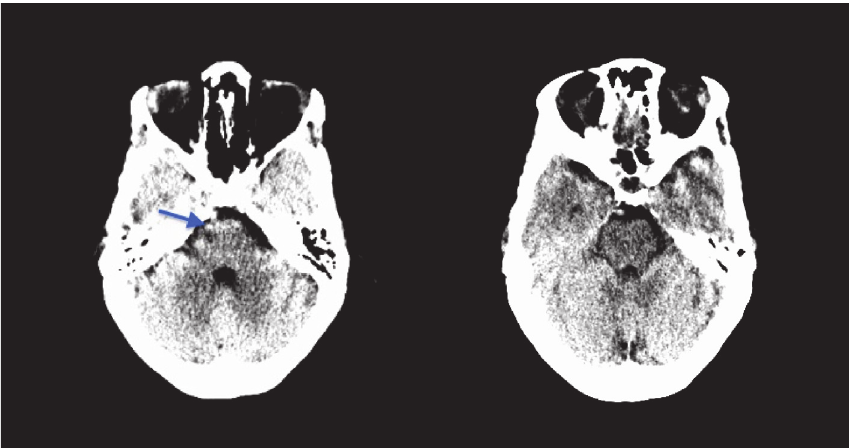
Figure 1: CT scan of the head on admission. Imaging shows no gross acute intracranial abnormality, except for mild bifrontal cerebellar atrophy and a 0.5 × 0.3 cm focal hypodense signal in the right pons (arrow), defined as beam hardening